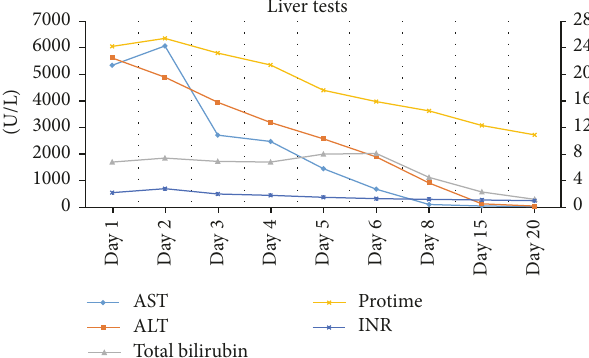
Figure 1: Changes in liver tests during hospitalization are plotted from admission at day 1 to day